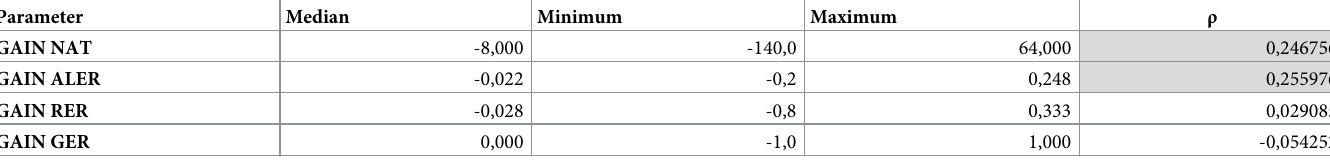
Table 6. Descriptive statistics of multisensory gain and correlation coefficients (Spearman’s ρ ).